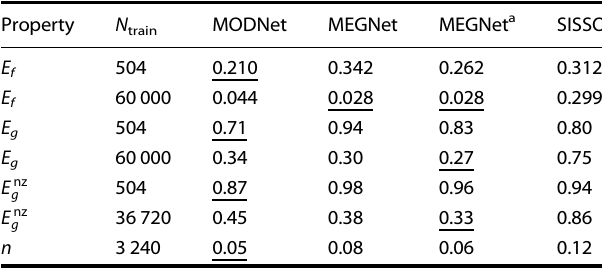
Table 1. Test accuracies with small and large training sizes for different machine learning algorithms.